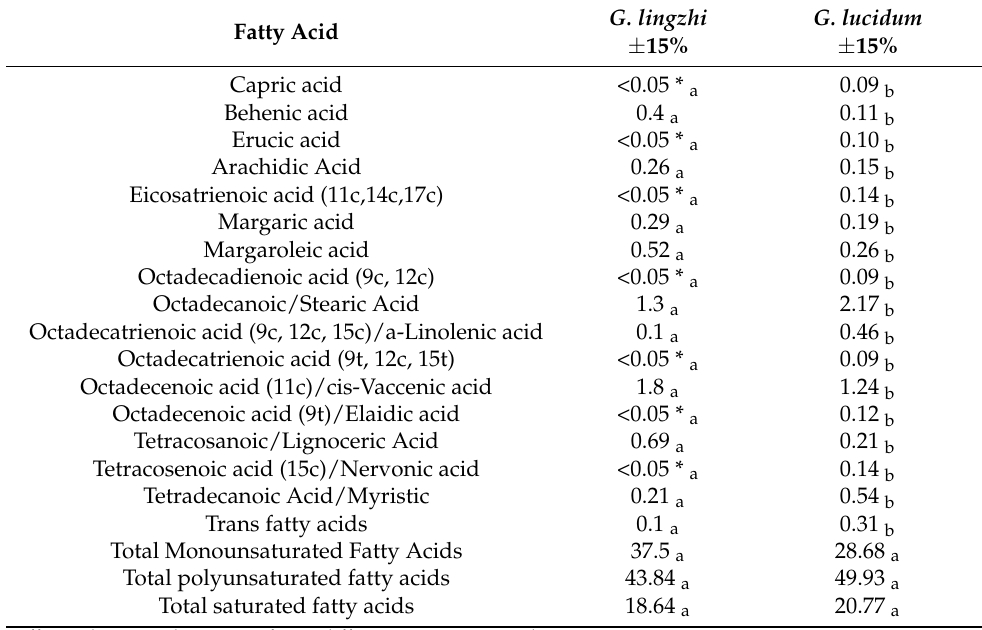
Table 3. Summary table of the differences in fatty acids content found between GZ carpophores from industrial crops in Shenzhen (China) and GL carpophores obtained by cultivating the Iberian GLM strain from Madrid (Spain), grown in Substrate 2: 20% rye and 80% Pyrenean oak. G. Fatty Acid